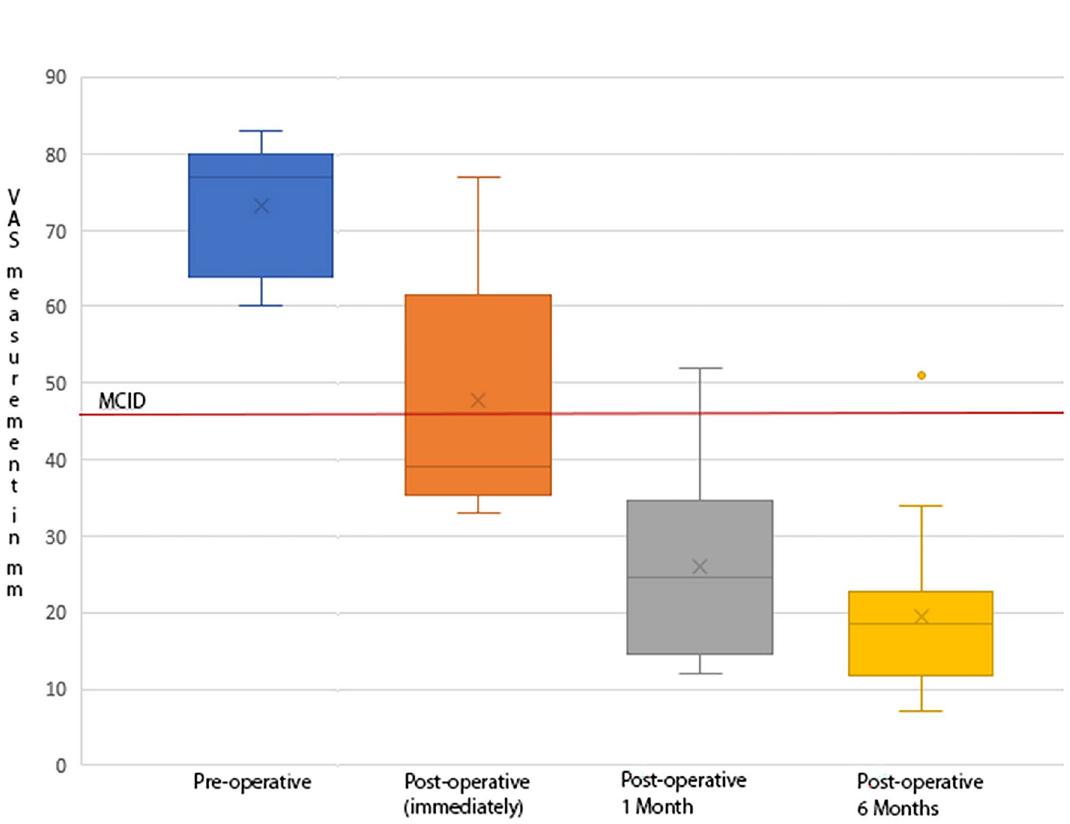
Figure 8. Arm pain intensity on visual analogue scale (VAS- Arm) before and after surgery. Minimal clinically important differences (MCID) = 26